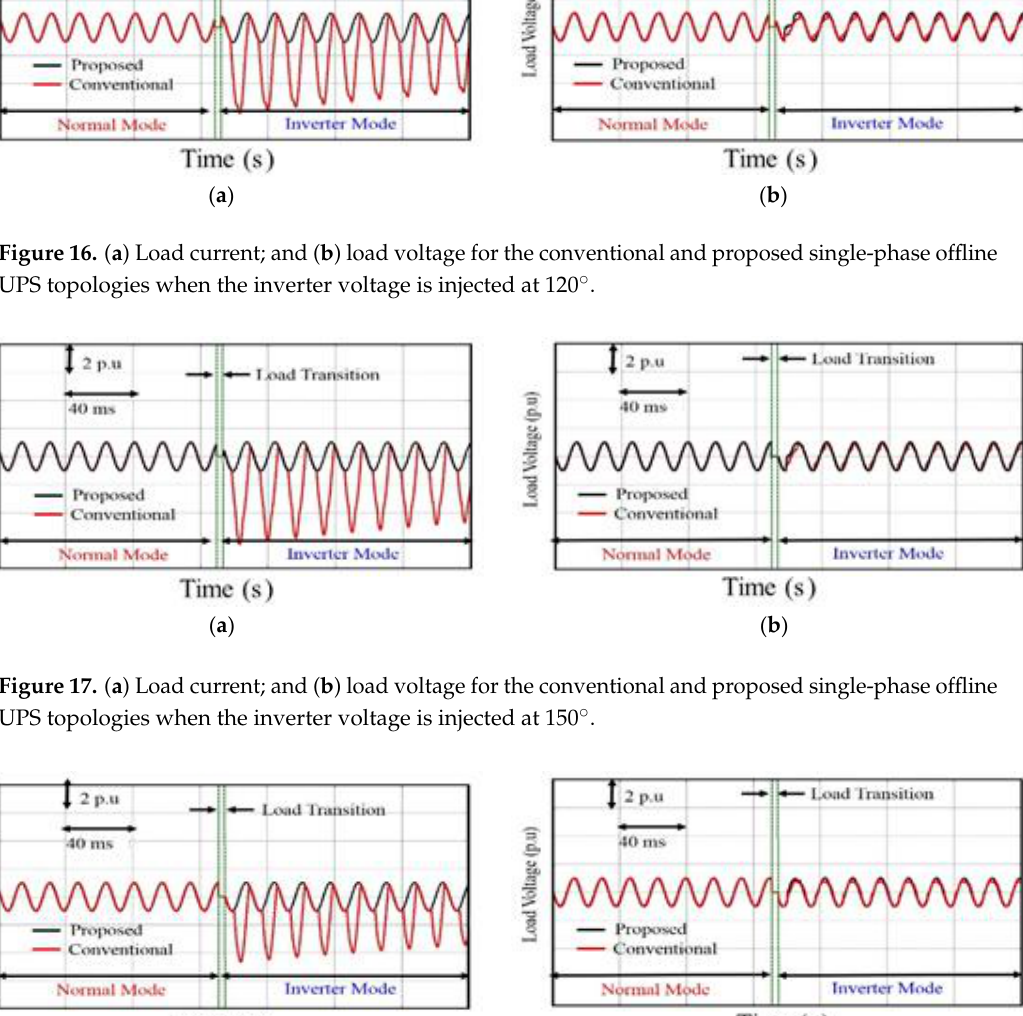
Figure 18. ( a ) Load current; and ( b ) load voltage for the conventional and proposed single-phase offline UPS topologies when the inverter voltage is injected at 180°.